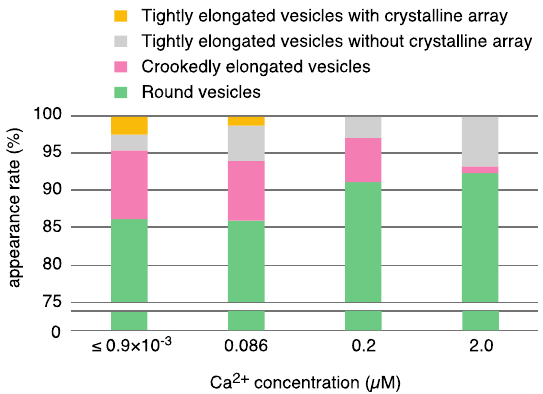
Figure 5. Bar plot showing the appearance rates of the various types of SR vesicle relative to the total number of vesicles imaged at ≤ 0.9 nM–2.0 µ M Ca 2+ . The vesicle classification reported in Table 1 was simplified to four types: tightly elongated vesicles with a crystalline array (yellow), tightly elongated vesicles without a crystalline array (gray), crookedly elongated vesicles (pink), and round vesicles (green). The rates are represented by the average percentages of the number of each vesicle type relative to the total number of vesicles imaged at the respective calcium concentrations. As indicated, the full range below 75% is not shown for the round vesicles, for convenience.